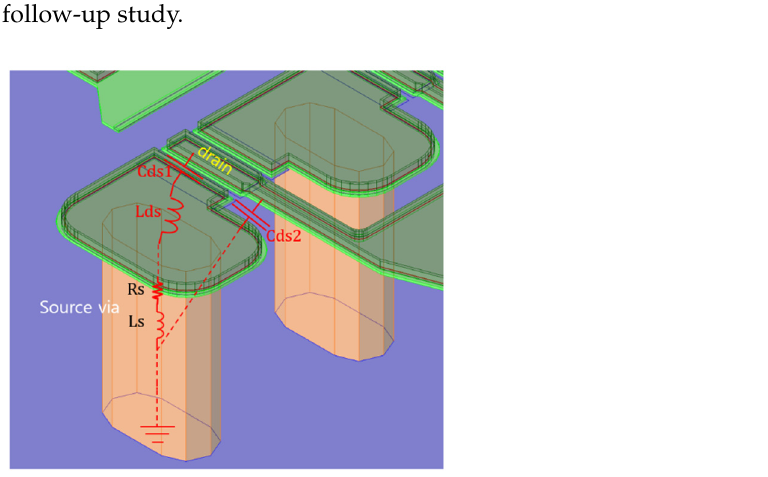
Figure 2. Enlarged source via structure of a GaN HEMT with its equivalent circuit.